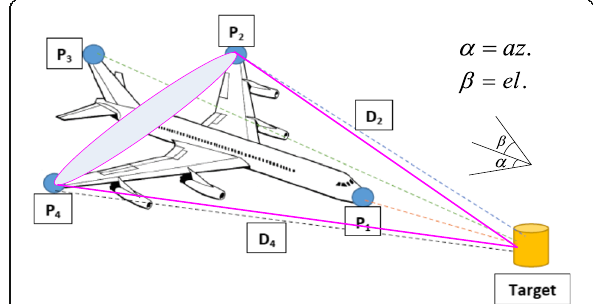
Fig. 5 Airborne ESM system for direction finding